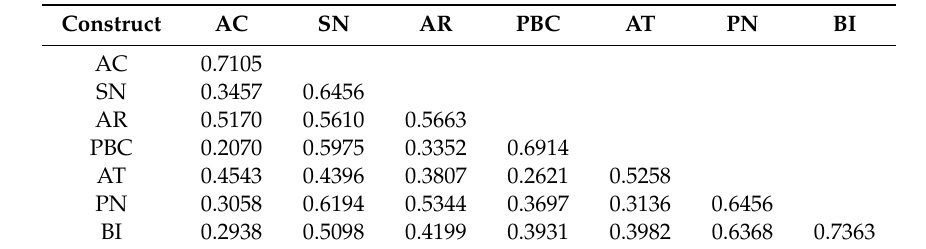
Table 3. Di ff erentiated validity test